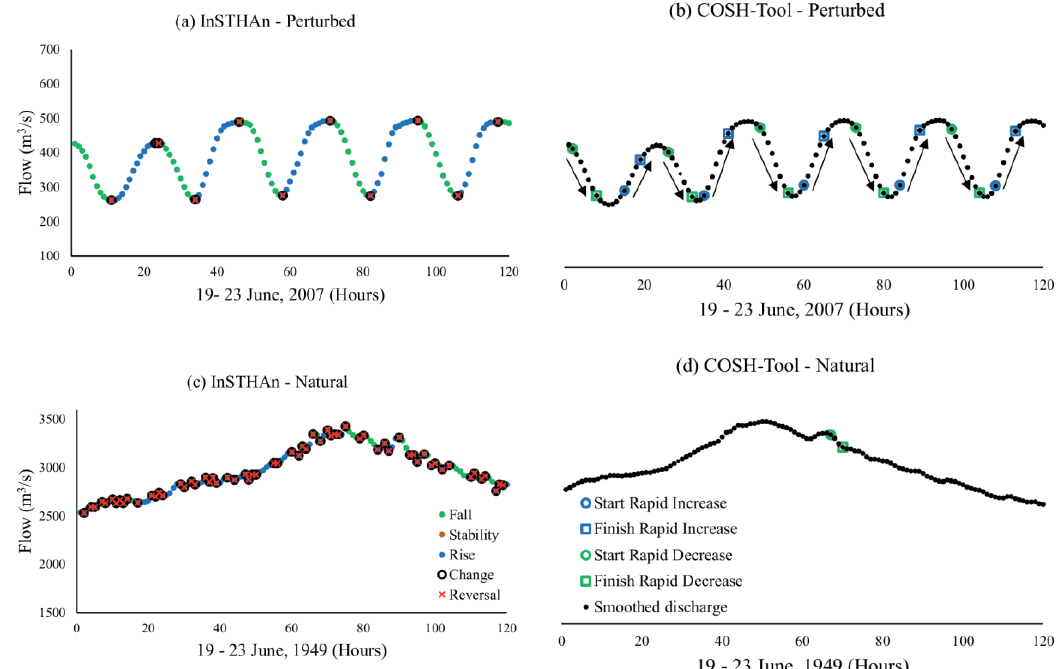
Figure 1. Patterns identified by InSTHAn ( a , c ; pre-dam) and COSH-Tool ( b , d ; post-dam) during five days in June, 2007 ( a , b ) and 1949 ( c , d ), in a hydrograph built on hourly flows recorded in the Colorado River reach downstream from the Glen Canyon dam. Dots represent the flow records, which are colored or marked according to their pattern for InSTHAn or to identify peaking events for COSH-Tool. The following figures were provided to COSH-Tool for peaking events identification: 4 and 96 as inferior and superior percentiles of the rate of change, 120 min as the minimum duration for a peak, 0.2 as the magnitude threshold to merge peaks and 180 min as the minimum duration between two consecutive peaks.